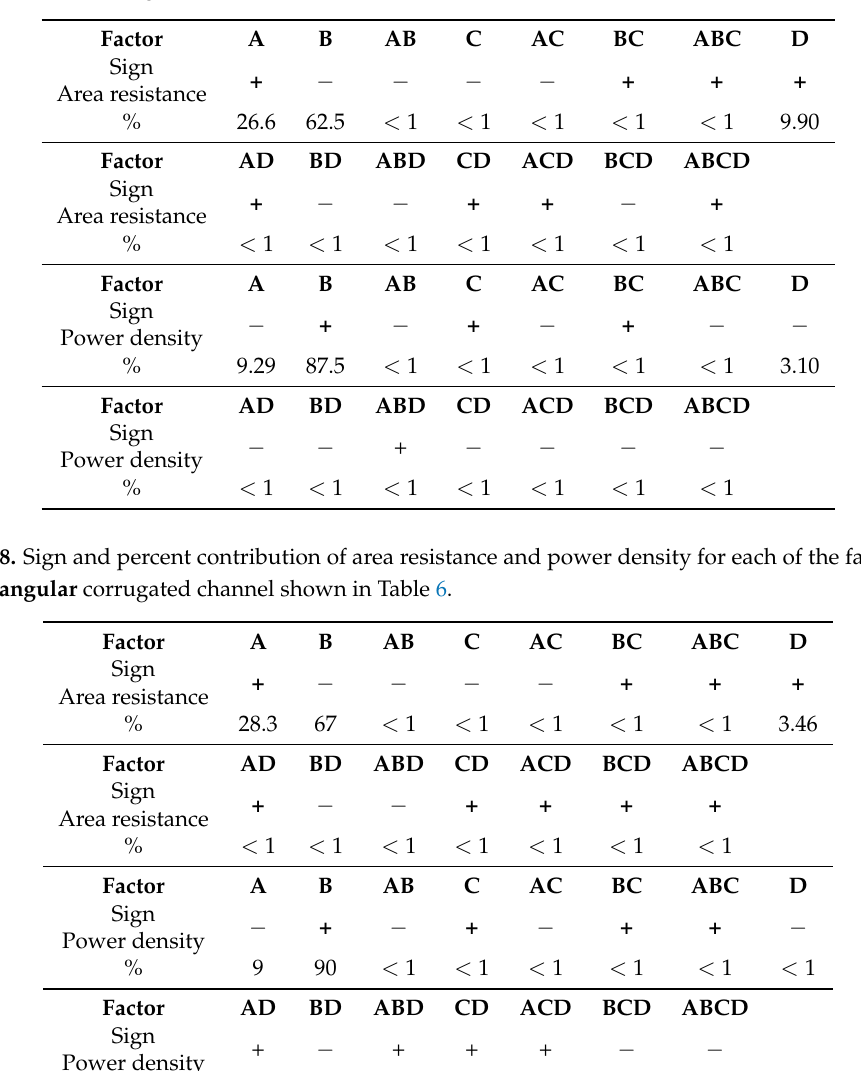
Table 7. Sign and percent contribution of area resistance and power density for each of the factors in the cylindrical corrugated channel shown in Table 5.